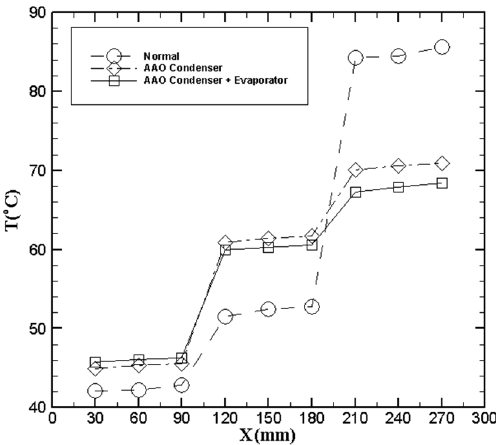
Figure 8. Temperature distributions of the heat pipes with single (condenser) and combined (evaporator + condenser) AAO nanostructured inner surfaces under an input heat power of 100 W at an anodizing voltage of 50 V and a treatment time of 9 h.